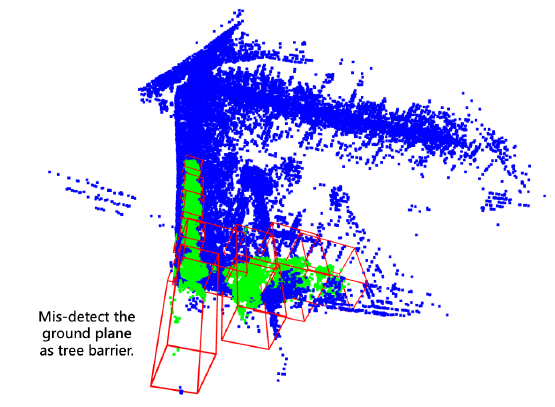
Figure 16. The detection results with ground plane reconstruction. The detection result of tree5 has messy ground plane noise.